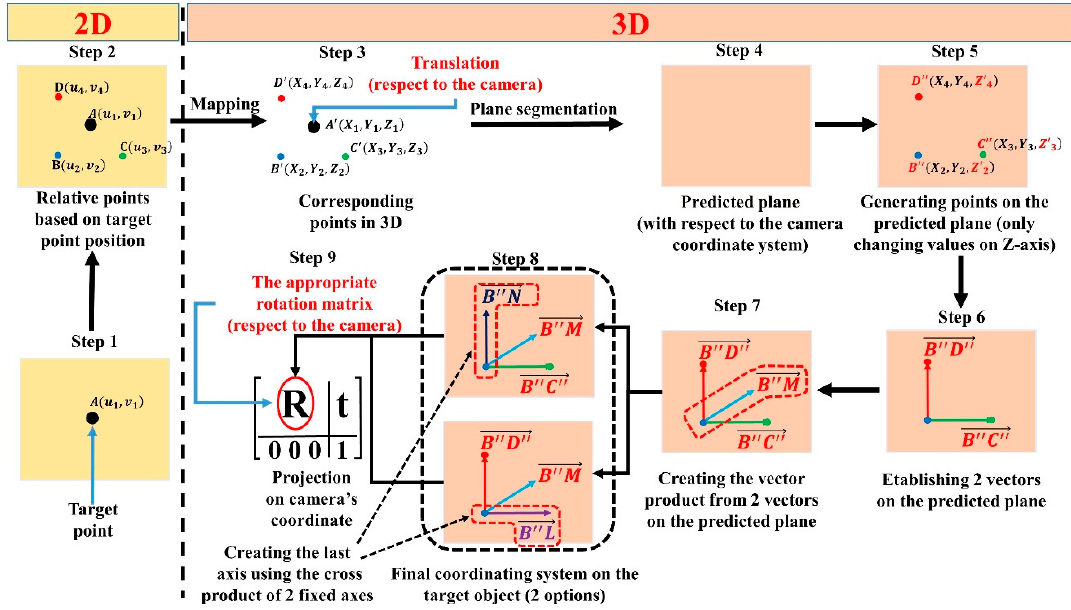
Figure 15. Procedure for building an appropriate coordinate system on the target object to create a rotation matrix with respect to the camera.